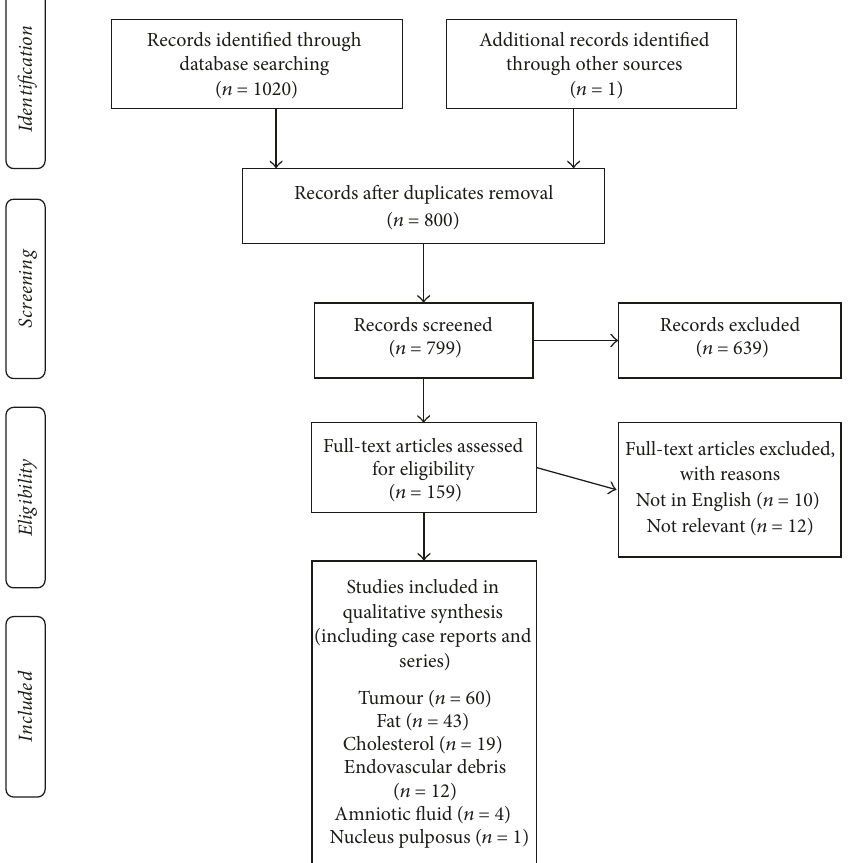
Figure 1: PRIMSA 2009 flow